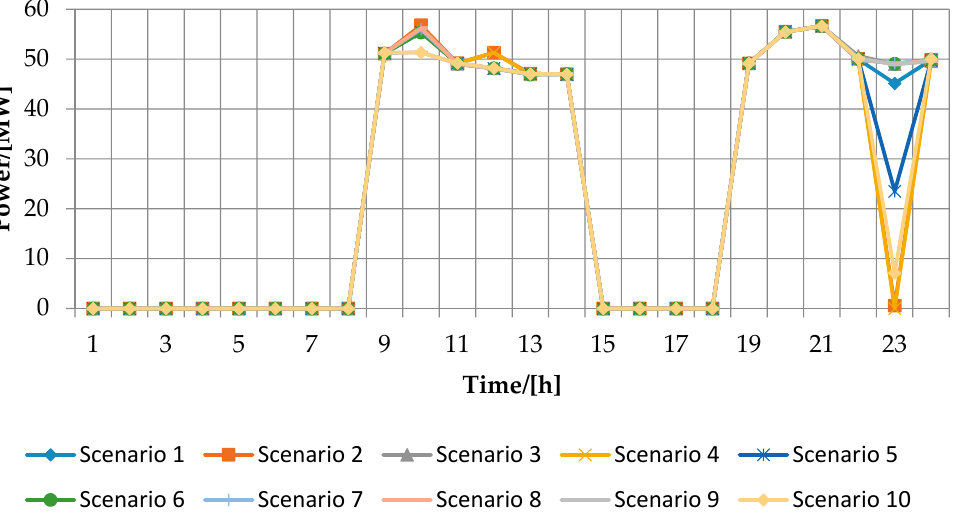
Figure 6. Load reduction curves in Mode 2.